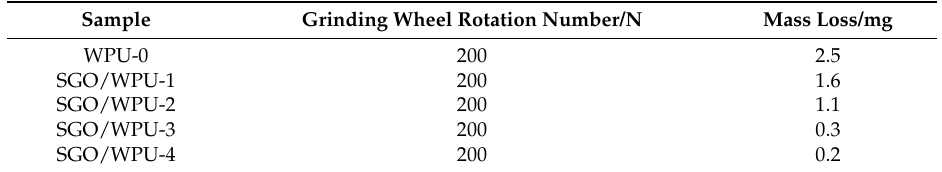
Table 3. Abrasion resistance of SGO/WPU composites with different SGO contents.